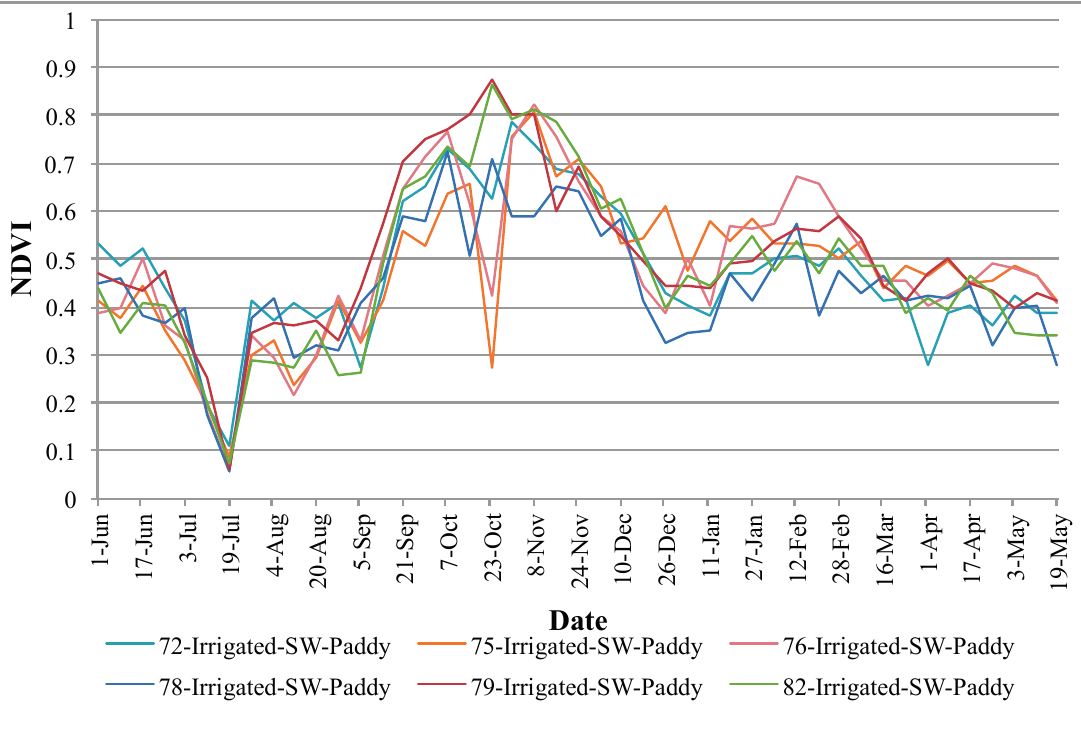
Figure 11. NDVI time series of observed rice fields, which are classified as rice pixels in the single crop rice